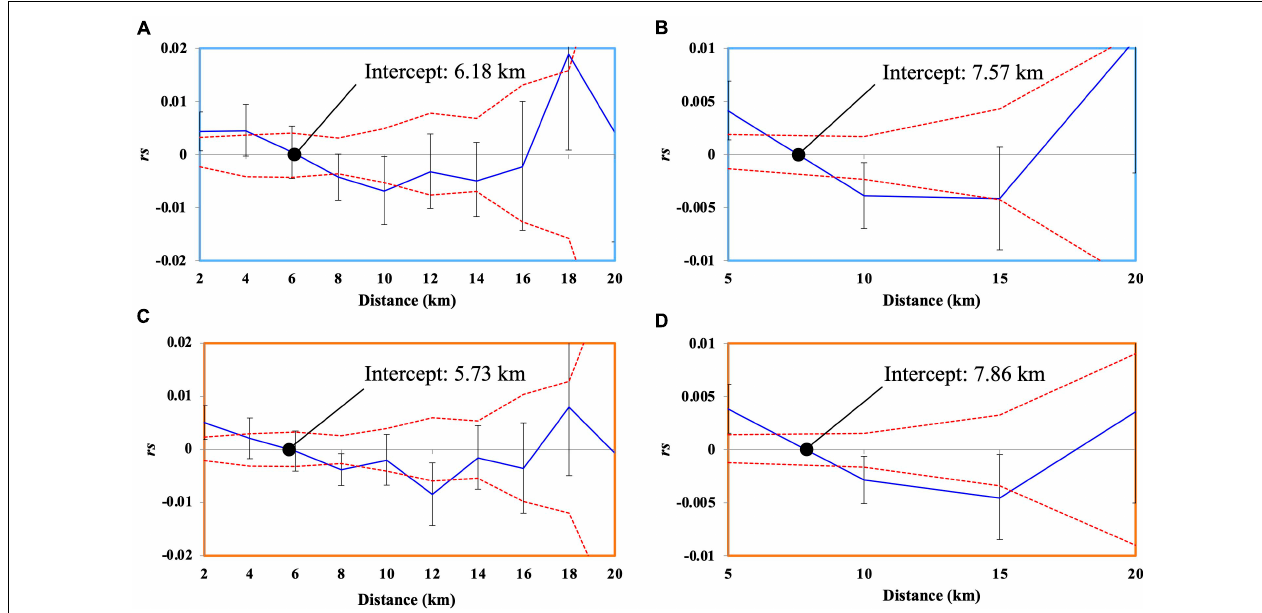
FIGURE 4 | Correlograms showing the spatial autocorrelation rs (here “ rs ” is used instead of “r” that is generally used for correlation coefficient of spatial autocorrelation analysis to avoid confusion with the ratio of missing data per locus “r”) across as a function of distance, 95% confidence interval about the null hypothesis of a random distribution of C. japonicum , and 95% confidence error bars about rs as determined by bootstrapping. Autocorrelation for distance class size of (A) 2 km using de novo (2,280 SNPs), (B) 5 km using de novo (2,280 SNPs), (C) 2 km using mapping method (892 SNPs), and (D) 5 km using mapping method (892